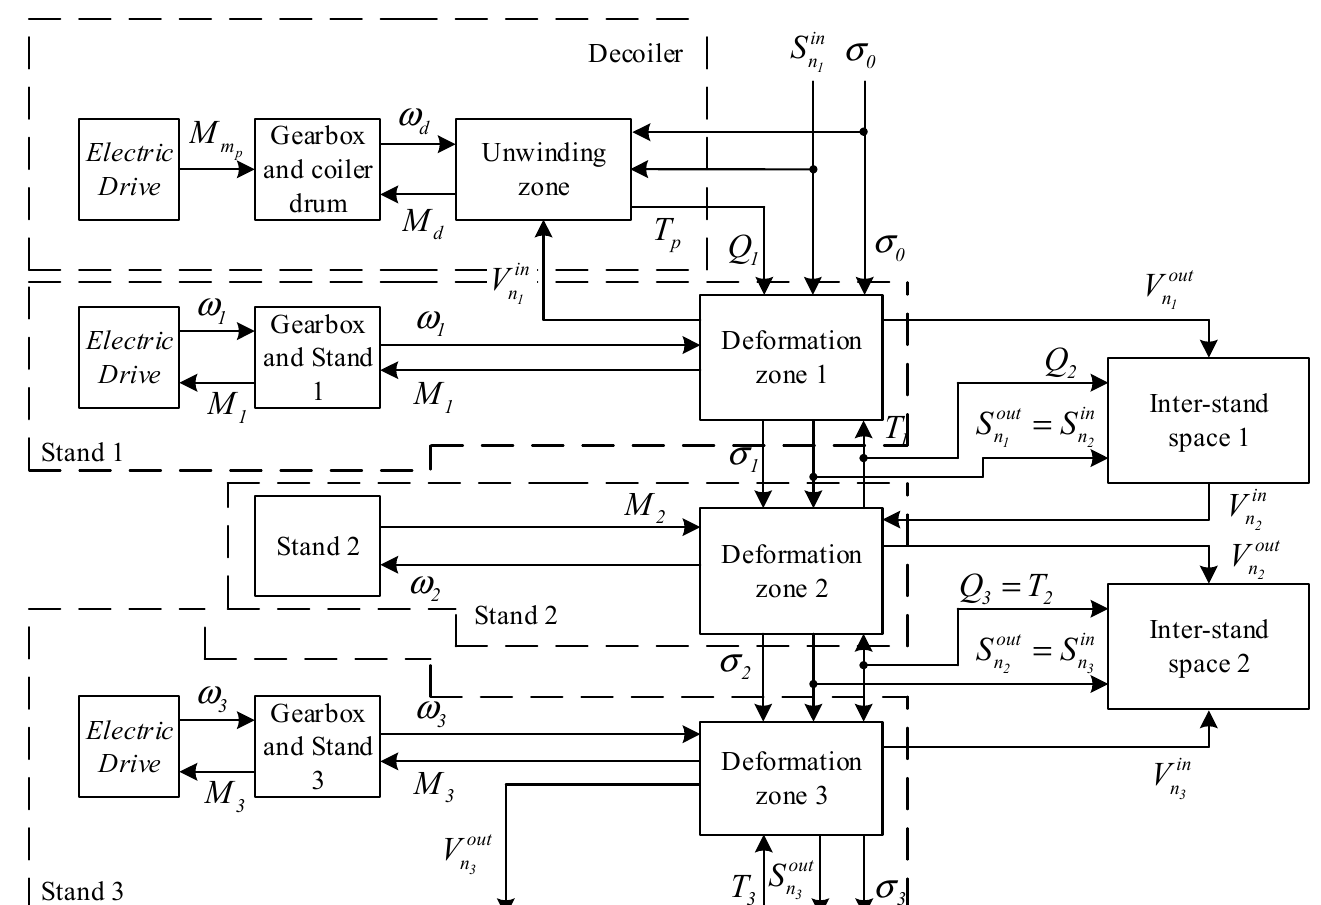
Figure 3. Simplified block diagram of a three-stand rolling section as a controlled object.